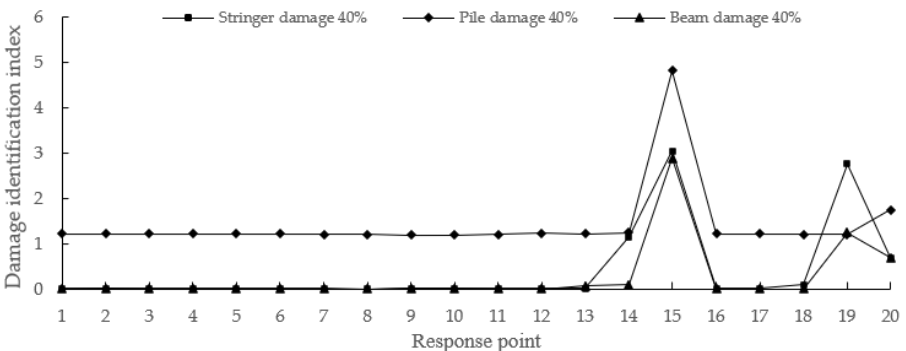
Figure 8. Variation curves of damage identification index at different damage locations of the struc- ture